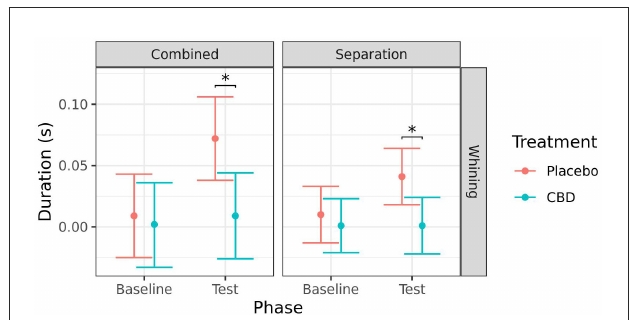
FIGURE7 Predicted mean (95% CI) duration of time spent whining(s) for dogs given CBD or placebo at each phase of testing (baseline and test) based on models analyzing both stress tests combined or separation test. Asterisks indicate significant differences between treatment groups within each phase. * p < 0.05.